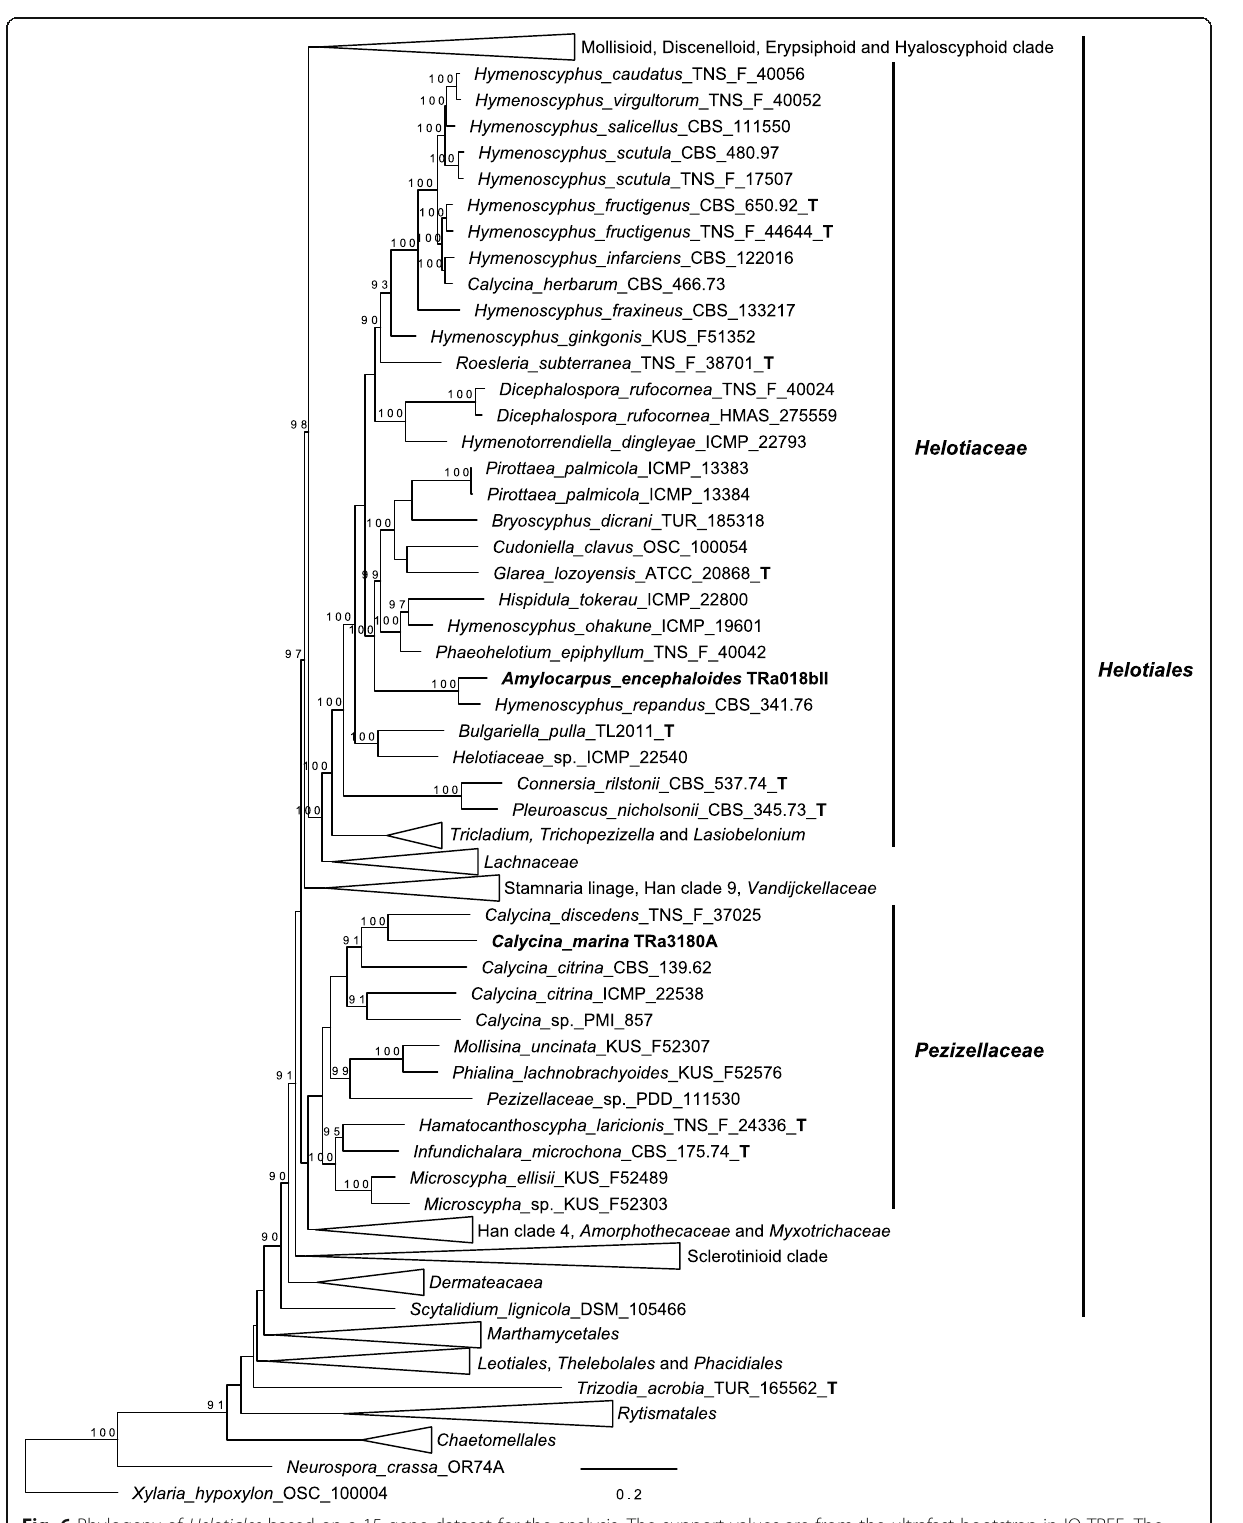
Fig. 6 Phylogeny of Helotiales based on a 15-gene dataset for the analysis. The support values are from the ultrafast bootstrap in IQ-TREE. The bold letter T denotes ex-type sequences. Xylaria hypoxylon was used as an